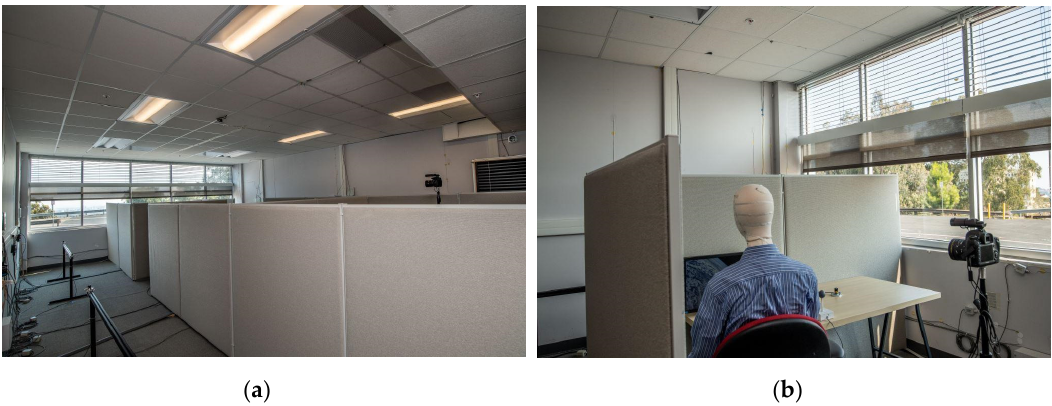
Figure 5. Photographs of Test System 2 setup in the lab: ( a ) view from back of test cell showing daylight dimming LED lighting system and three office cubicles; ( b ) view of cubicle near windows, with HDR camera for glare evaluation at occupant seated position. The mechanized roller shades and daylight redirecting blinds are shown along the window wall.